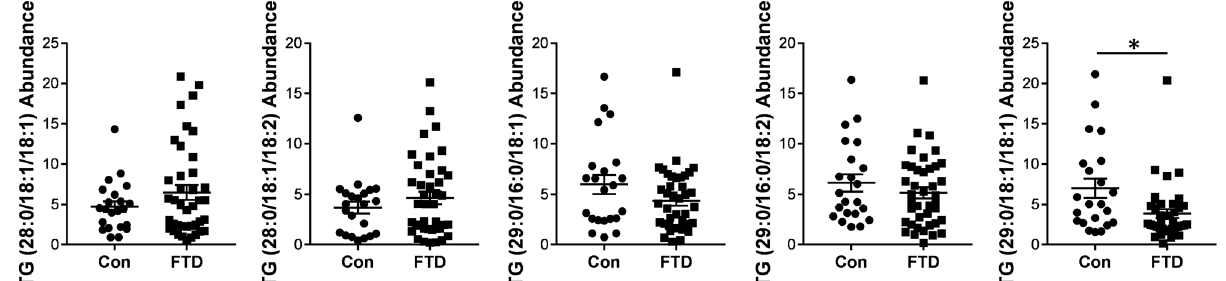
Figure 5. Assessment of VLCFA-lipids in FTD serum. Quantitative discovery lipidomics LC/MS detected five VLCFA-TG species in the human serum, of which one was significantly decreased in FTD (n = 40) compared to controls (n = 22). Relative abundance of lipids was obtained from LC/MS peak areas normalized to internal standards. Multivariate analysis (general liner model), co-varying for age and sex, was used to determine significance between the two groups. Data represent mean and SE as error bars, * P <